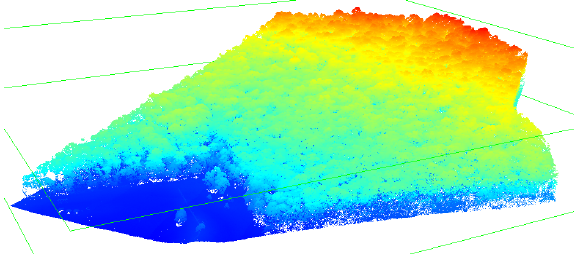
Figure 7: Point Cloud data of Vermont Place Park, Newcastle, Australia. Source: Fire and Rescue NSW.